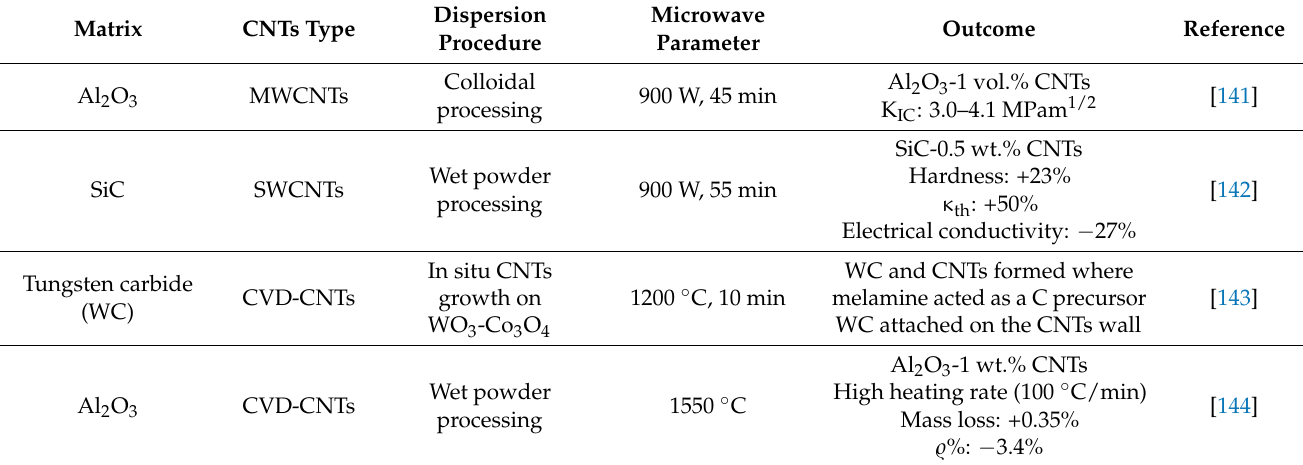
Figure 14. ( a ) Optical image and transmission electron microscopy (TEM) micrograph (inset), and ( b ) the energy dispersive X-ray spectroscopy (EDX) spectrum of SWCNTs-SiC composite. (Adapted with permission from ref. [138]. Copyright 2006 Elsevier.) Table 8. Literature database of CNTs-CMCs via microwave-assisted sintering.